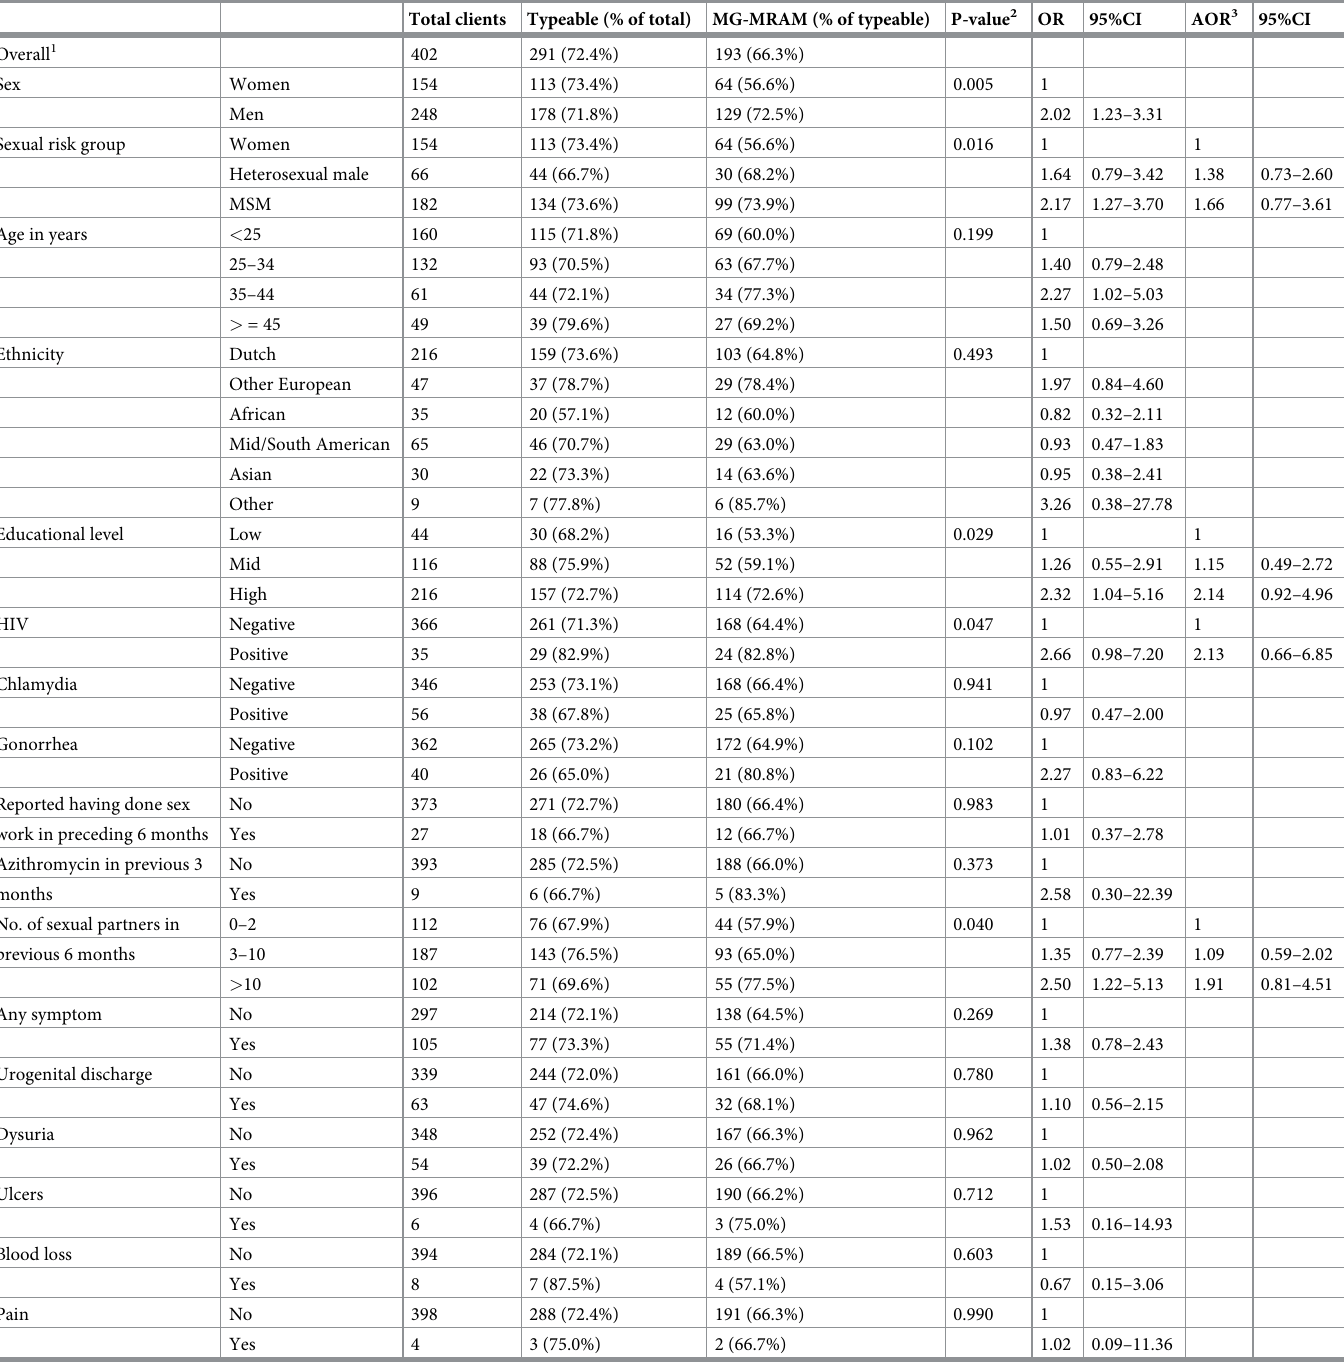
Table 4. Prevalence of MG-MRAM among clients of the STI outpatient clinic in Amsterdam and The Hague according to different client characteristics, and results of logistic regression analysis for association of characteristics with presence of